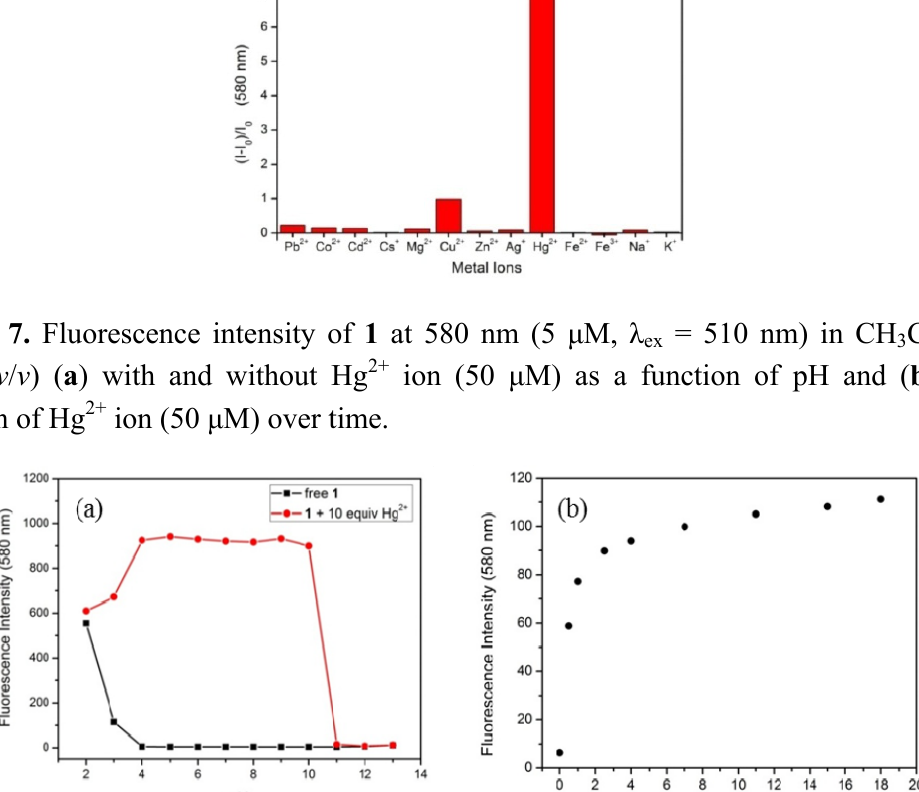
Figure 6. Bar profiles of fluorescence intensity for chemosensor 1 (5 μ M, λ CN/HEPES (95/5, v / v ) upon addition of 10 equiv of various metal ions as perchlorates. CH 3